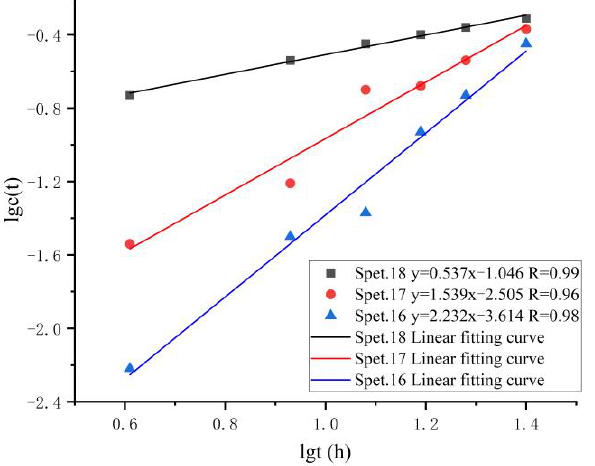
Figure 6. Temporal fractal fitting of microseismic events during rock burst.